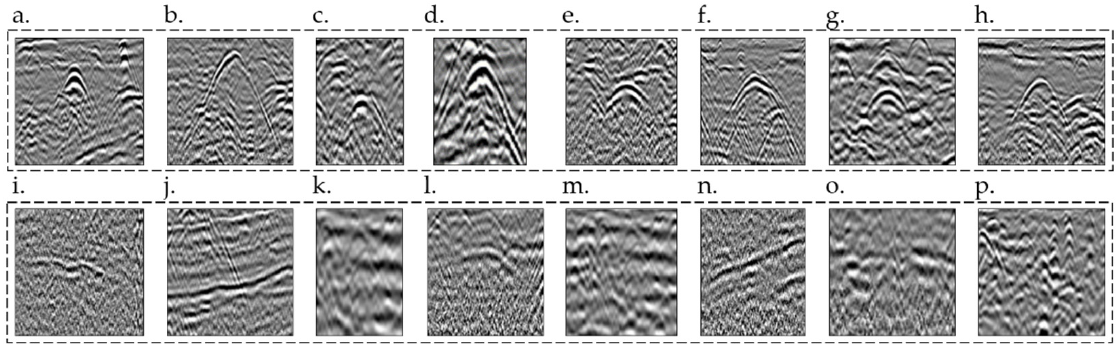
Figure 3. An example of the candidate objects of the database: ( a – h ) true; ( i – p ) false. The hyperbolas selected manually in radargrams were then selected and assigned to one of three classification groups: G1 – G3 . Hyperbolas were marked in green ( G1 ), orange ( G2 ), and red ( G3 ). Figure 4 presents an example of the selection of candidate objects on a fragment of the selected radargram obtained in the first measurement series.